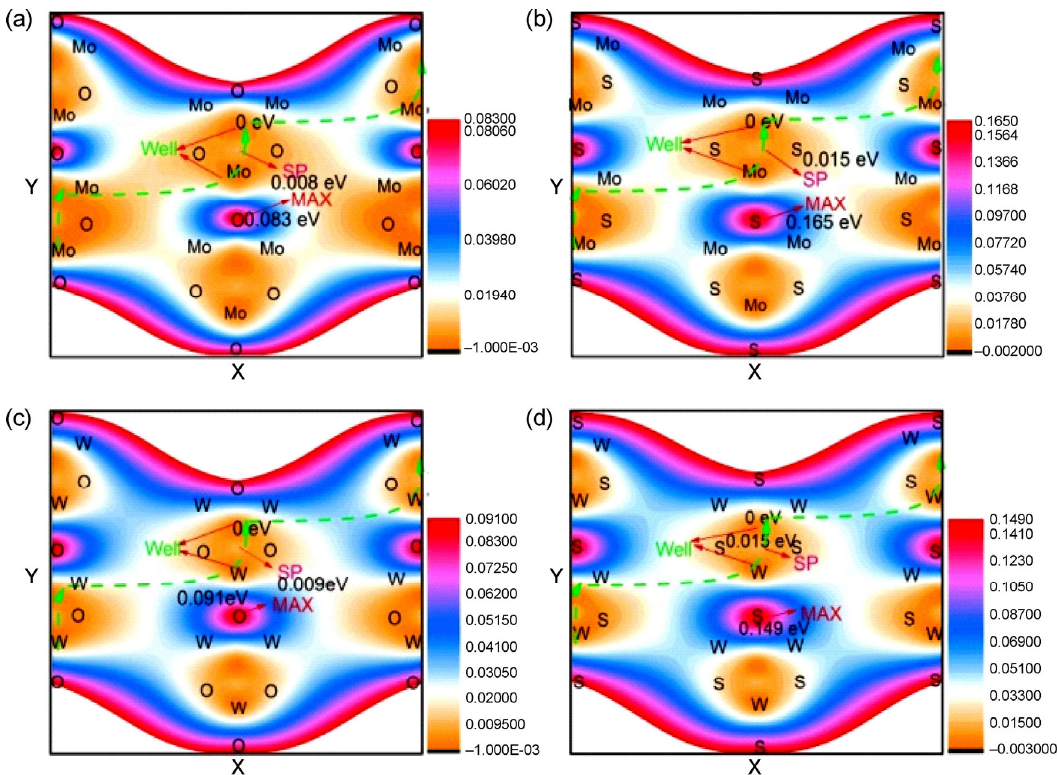
Fig. 4 Static potential surfaces of (a) MoO 2 , (b) MoS 2 , (c) WO 2 and (d) WS 2 at their equilibrium interlayer distance. Well indicates the minimum interaction energy, SP indicates the saddle point, and MAX indicates the maximum interaction energy. The curved arrows indicate the minimum energy sliding